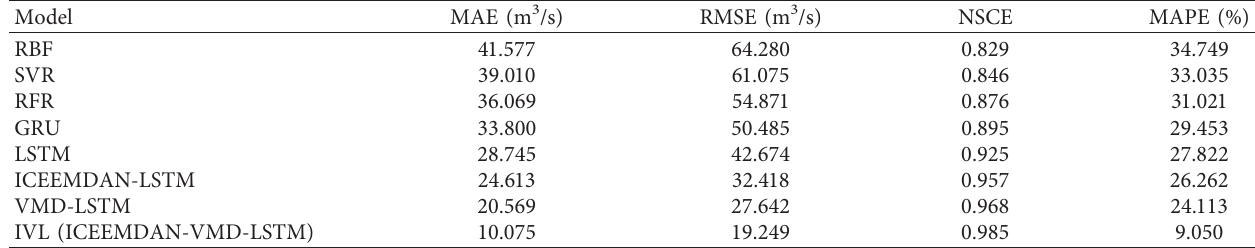
Table 3: Comparison of models using statistical metrics during the testing period.